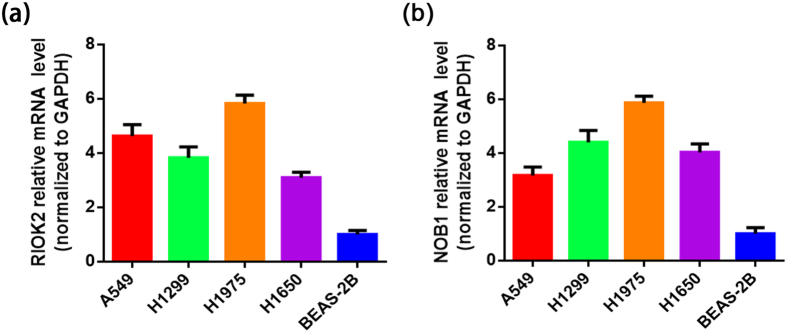
RIOK2 and NOB1 mRNA expression levels in NSCLC cells.(a) The RIOK2 mRNA level in the NSCLC cell lines (A549, H1299, H1975 and H1650) was higher than that in the normal lung cell line (BEAS-2B); (b) The NOB1 mRNA level in the NSCLC cell lines (A549, H1299, H1975 and H1650) was higher than that in the normal lung cell line (BEAS-2B).